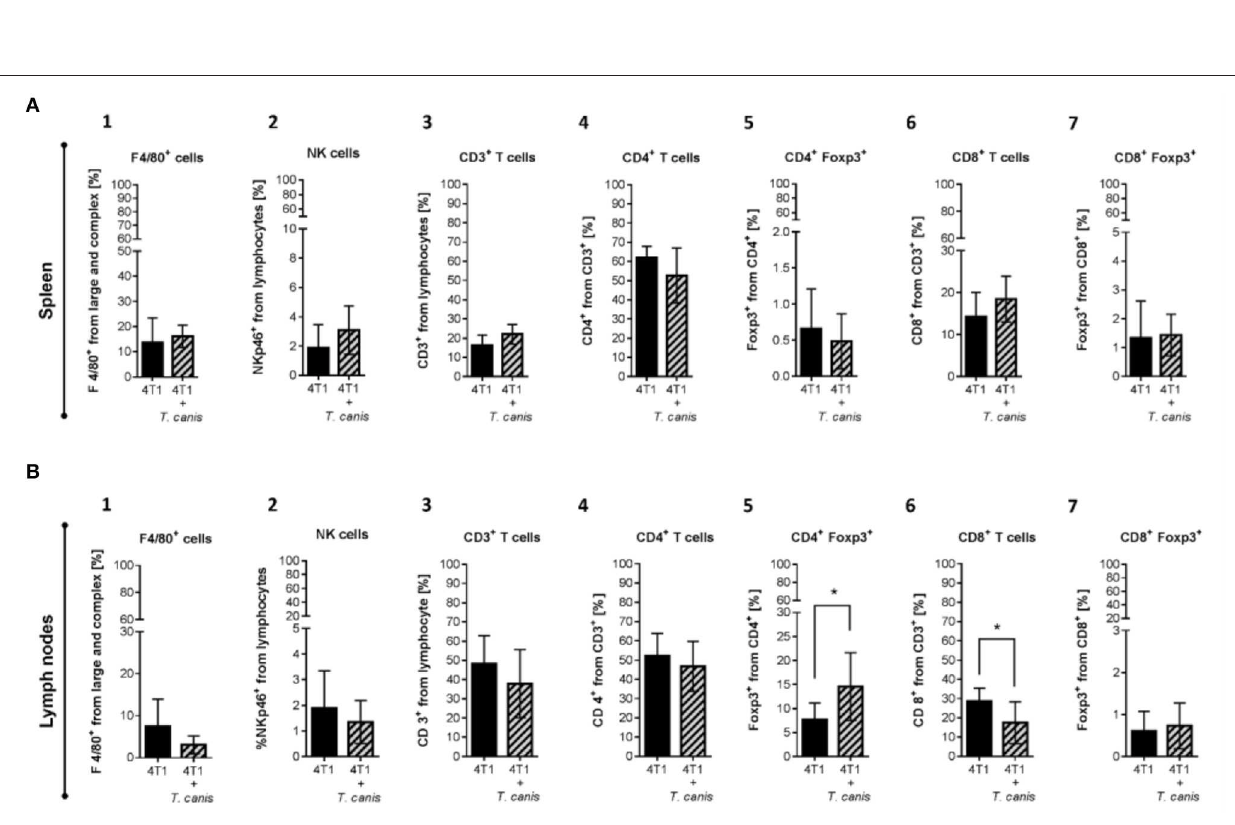
Frontiers in Oncology |